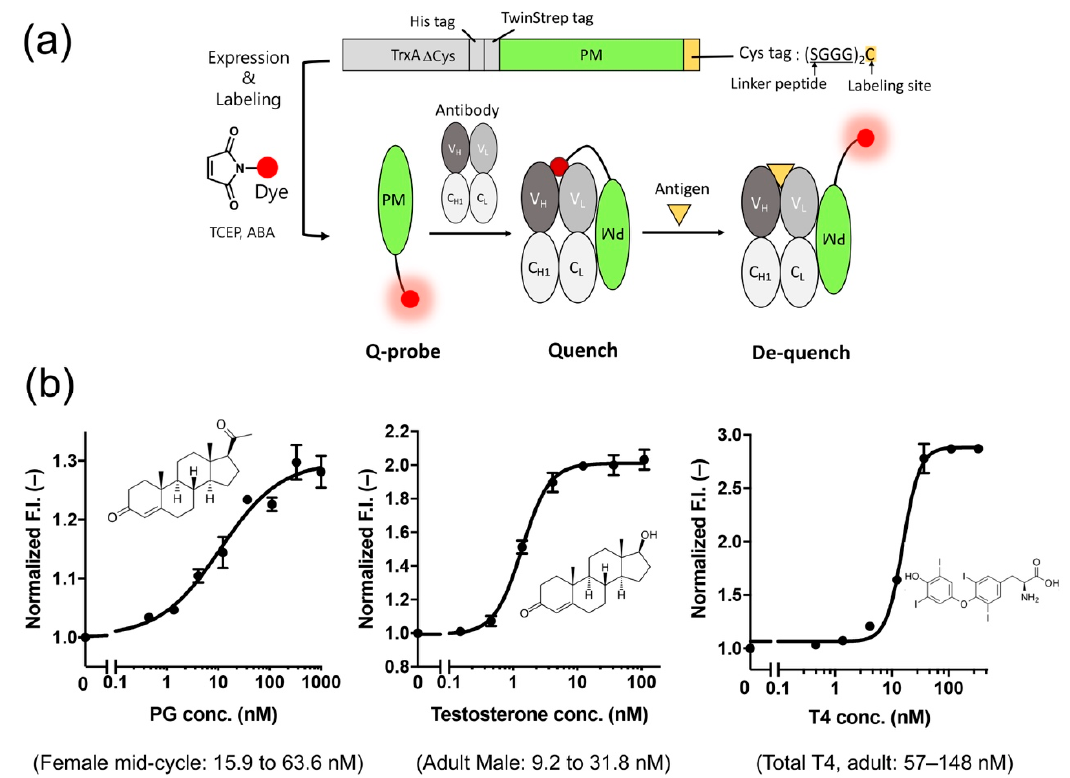
Figure 6. ( a ) Scheme of the structure and use of the PM Q-probe. ( b ) Results of small molecule detection using the IgG/PM Q-probe complex. The normal concentration range in blood for each dose-response is shown in parentheses. Modified with permission from [52].